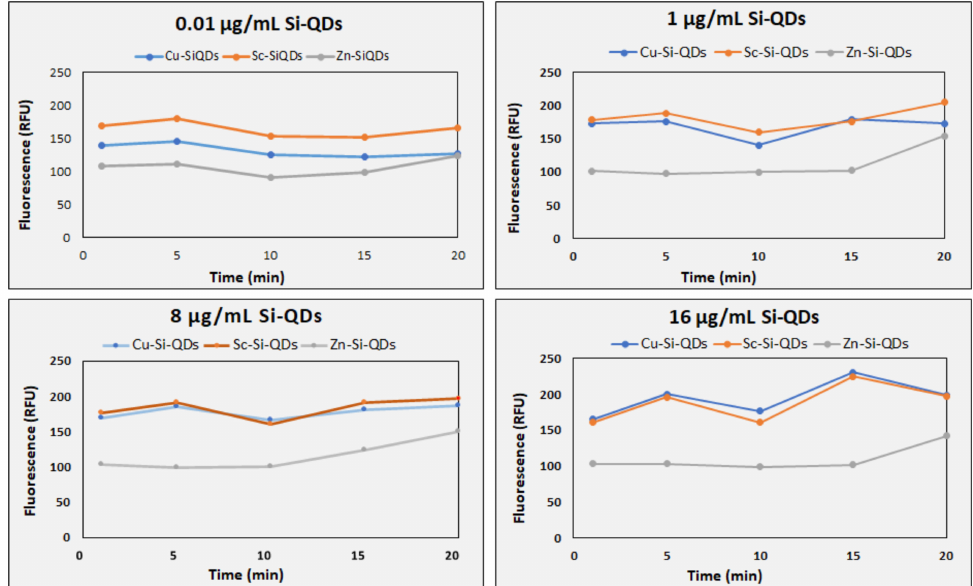
Figure 4. Time series of the fluorescence emission of the Cu-SiQDs, Sc-SiQDs, and Zn-SiQDs at four concentrations (0.01, 1, 8, and 16 ug/mL) at five different time points (1, 5, 10, 15, and 20 min). RFU: Relative fluorescence